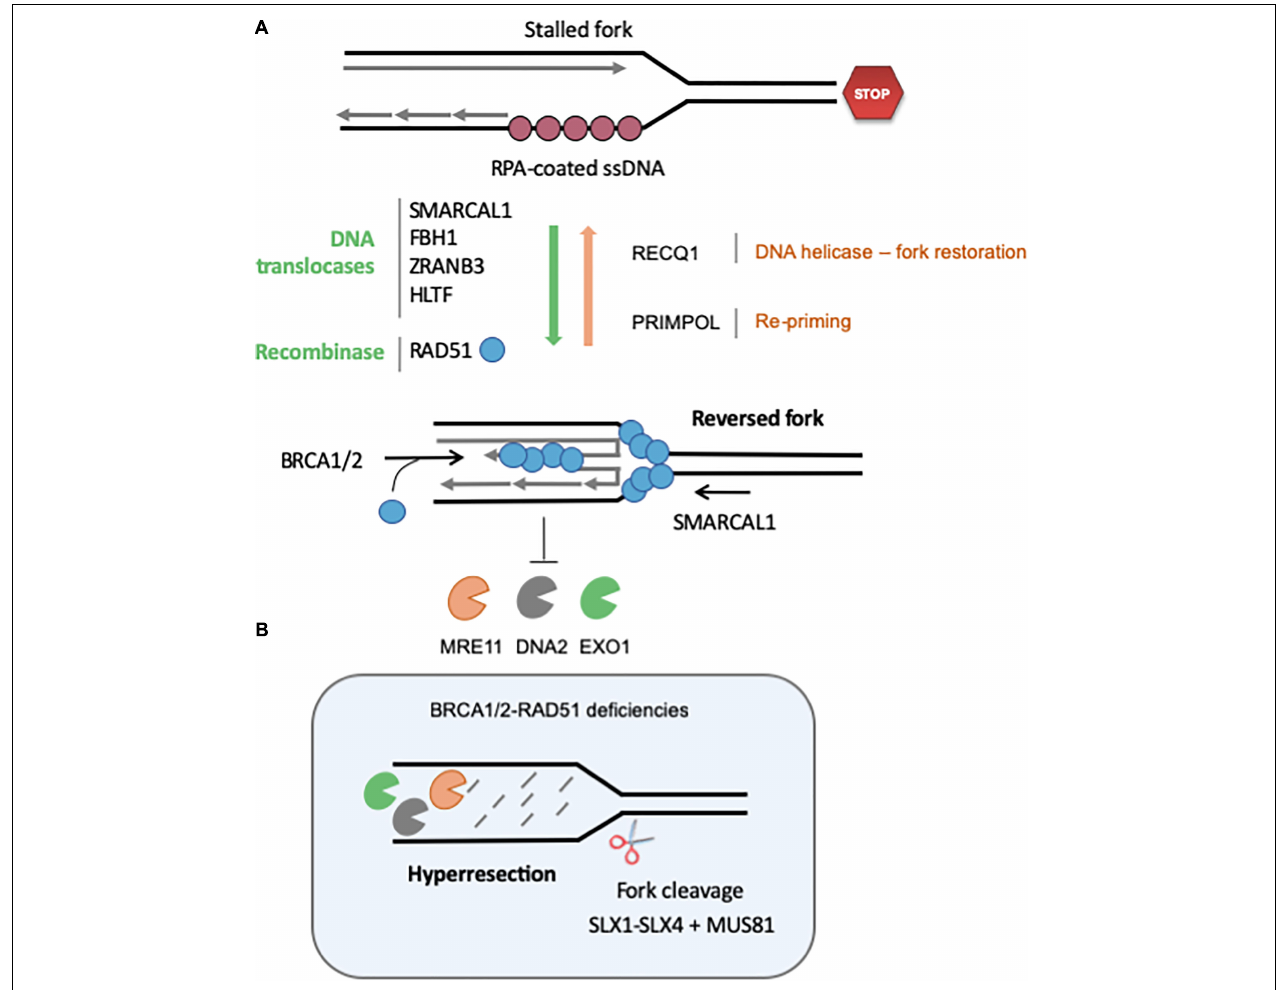
FIGURE 3 | Regulation of the formation and stability of reversed fork. (A) Fork reversal results from the re-annealing of parental strands, zipping the fork backward and promoting the pairing of nascent strands. Fork reversal is highly regulated, and many factors are currently known to regulate the balance between RVF formation, stabilization and restart. Redundant DNA translocases, namely SMARCAL1, FBH1, ZRANB3, and HLTF, have been described to promote fork regression in vitro and in vivo . The recombinase RAD51 also promotes fork reversion in a BRCA2-independent manner, although it is not clear whether its strand invasion property is required. RECQ1 is the major helicase known to promote restoration of the normal fork structure. PARP1 inhibits RECQ1-mediated fork restoration. Re-priming of DNA synthesis through PrimPol favors fork restart and reduces the frequency of fork regression. Once formed, RVF are stabilized by BRCA2-mediated loading of RAD51 on the regressed arm. (B) If BRCA-RAD51 fork protection is not functional, the regressed arm is extensively degraded by MRE11, DNA2 and EXO1. Eventually, the SLX1-SLX4-MUS81 endonucleases can cleave these structures to rescue forks. See text for further